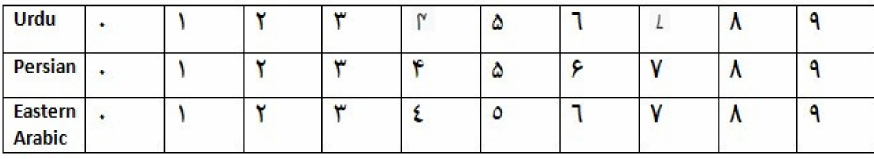
Figure 1. Urdu, Persian, and Eastern Arabic numerals.